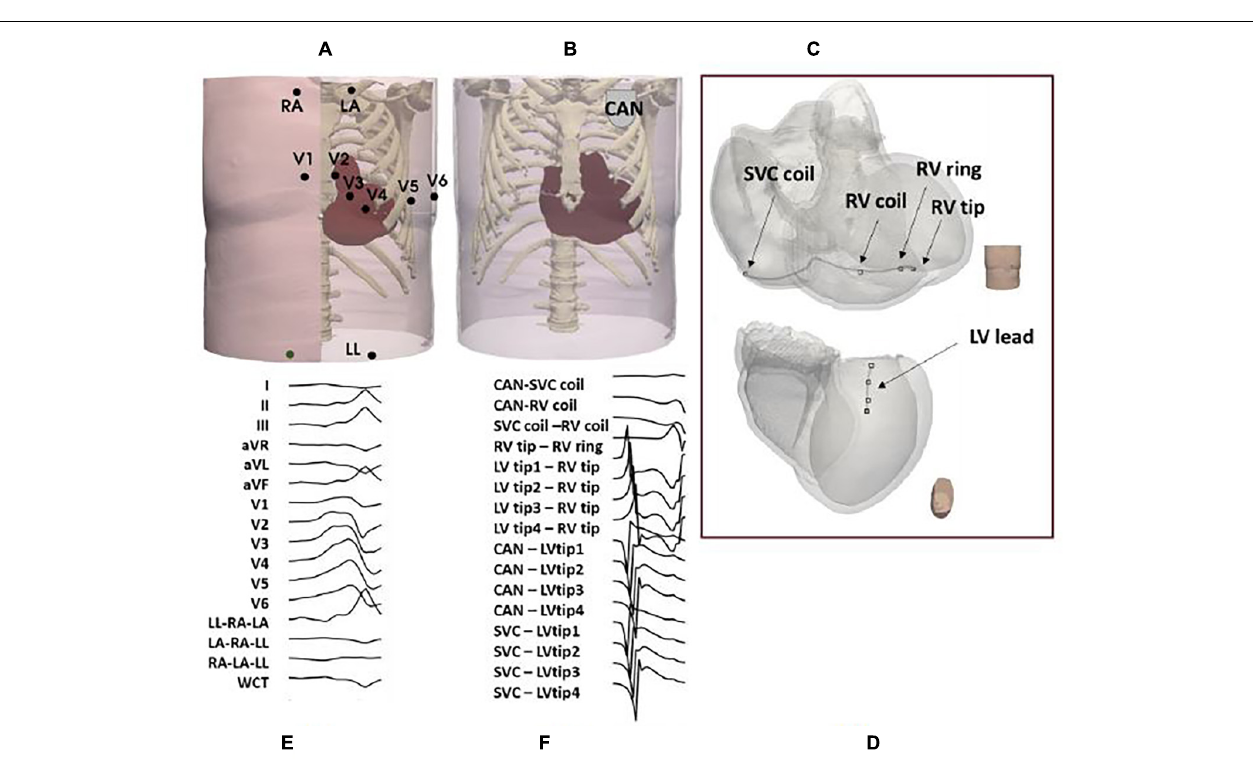
FIGURE 4 | Torso setup. ECG and CIED configurations are shown in (A–D) . Example of 16 combinations of pacing signals used for training and testing are illustrated in (E) for ECGs and (F) for